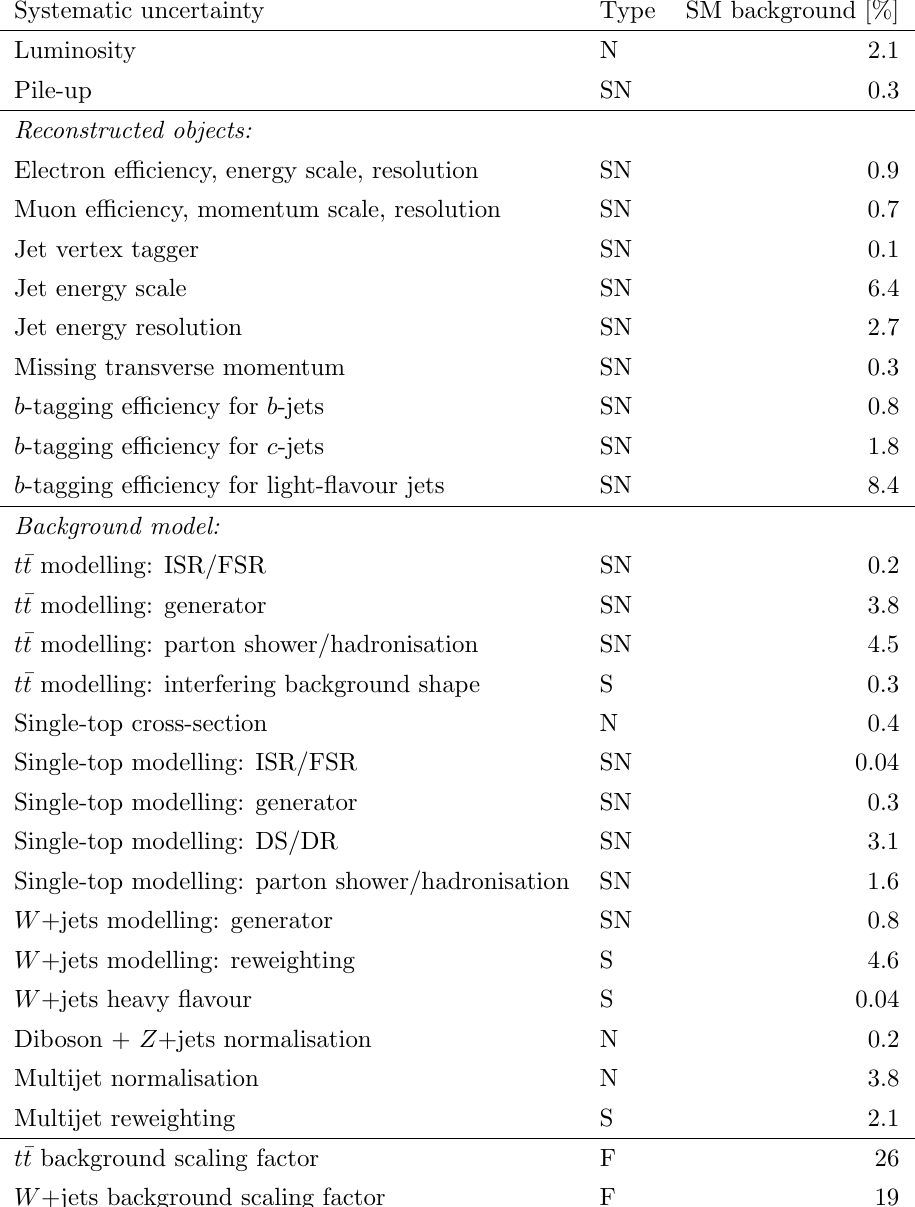
Table 3. Systematic uncertainties considered in this analysis. An uncertainty that a(cid:11)ects normal- isation only (cross-section only) for all processes and channels is denoted by \N", whereas \SN" means that the uncertainty a(cid:11)ects both shape and normalisation and \F" means a (cid:13)oating nor- malisation uncertainty. Some of the systematic uncertainties are split into several components for a more accurate treatment. The relative systematic uncertainties in the inclusive expected SM background yields determined from the VLQ candidate invariant mass distribution after the (cid:12)t to the background-only hypothesis are given in the last column in percentage. The t (cid:22) t and W +jets background scaling-factor uncertainties (last two rows in the table) are the relative systematic uncertainties in the predicted t (cid:22) t and W +jets background respectively.